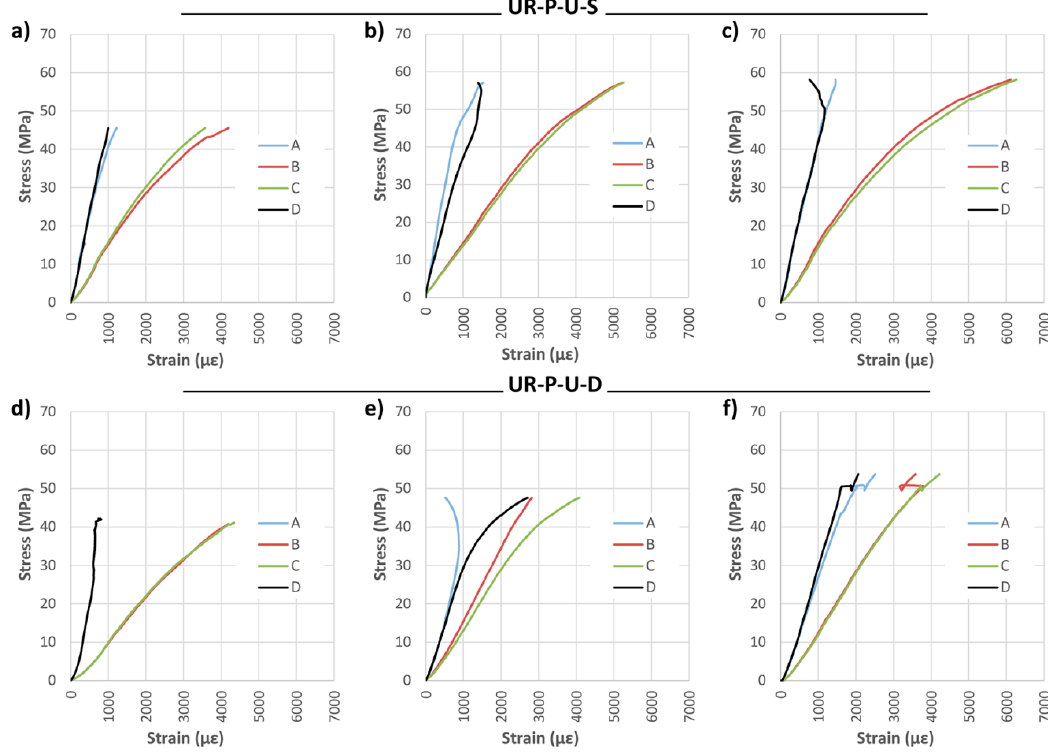
Figure 20. Stress against strain during bending tests: ( a ) UR-P-U-S-1; ( b ) UR-P-U-S-2; ( c ) UR-P-U-S-3; ( d ) UR-P-U-D-1; ( e ) UR-P-U-D-2; and ( f ) UR-P-U-D-3. CFRP supplier: SIKA ® and DRIZORO ®